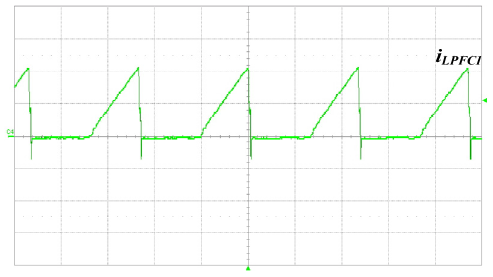
Figure 7. Measured inductor current i LPFC 1 (0.5 A/div); time scale: 5 μ s/div.